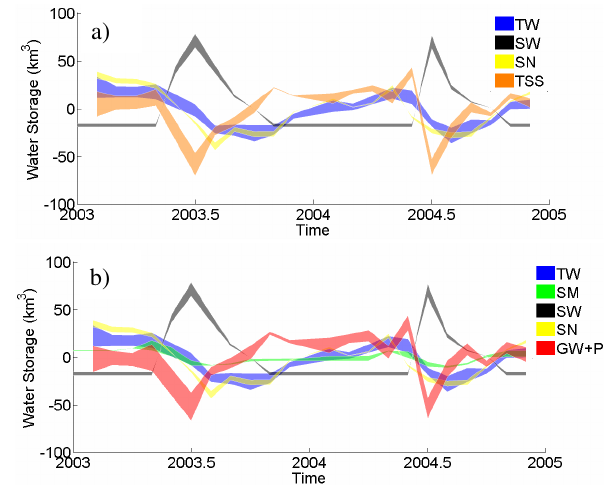
Figure 7. a) Monthly variations of TWS volume (blue), surface water volume from T/P radar altimetry and multisatellite inundation dataset (black), snow derived from GRACE measurements (yellow), TSS by difference between TWS and the other compartments (orange), Monthly variations of TWS volume (blue), surface water volume from T/P radar altimetry and multisatellite inundation dataset (black), soil moisture from hydrological model outputs (green), snow derived from GRACE measurements (yellow), sum of groundwater and permafrost by difference between TWS and the other compartments (red). Units: km 3 .